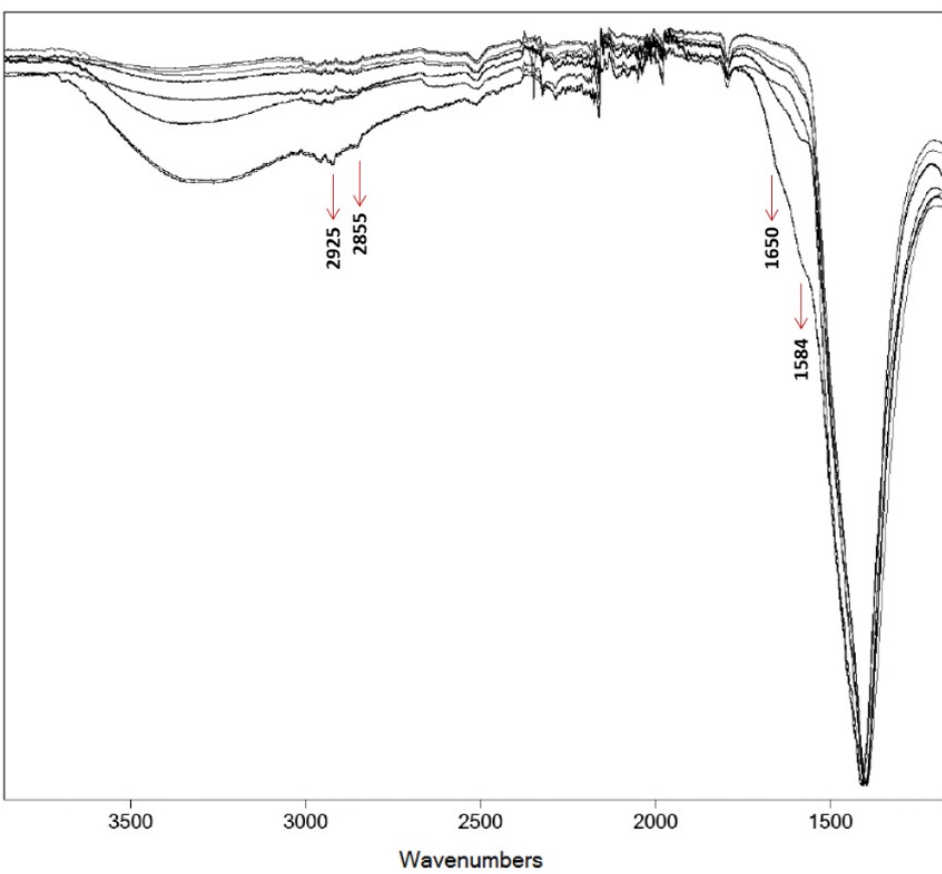
Figure 11. FTIR spectral details showing specific features that infer the presence of an organic binder within the investigated samples from Ulpia Traiana Sarmizegetusa.